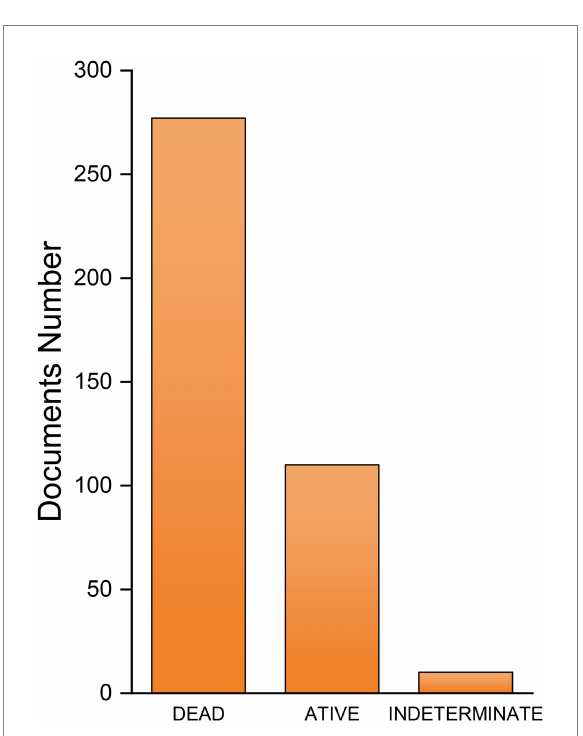
FIGURE 3 Current status of patents with keywords “fermentation” and “single cell protein” or “single-cell protein” extracted from Derwent World Patents Index ™